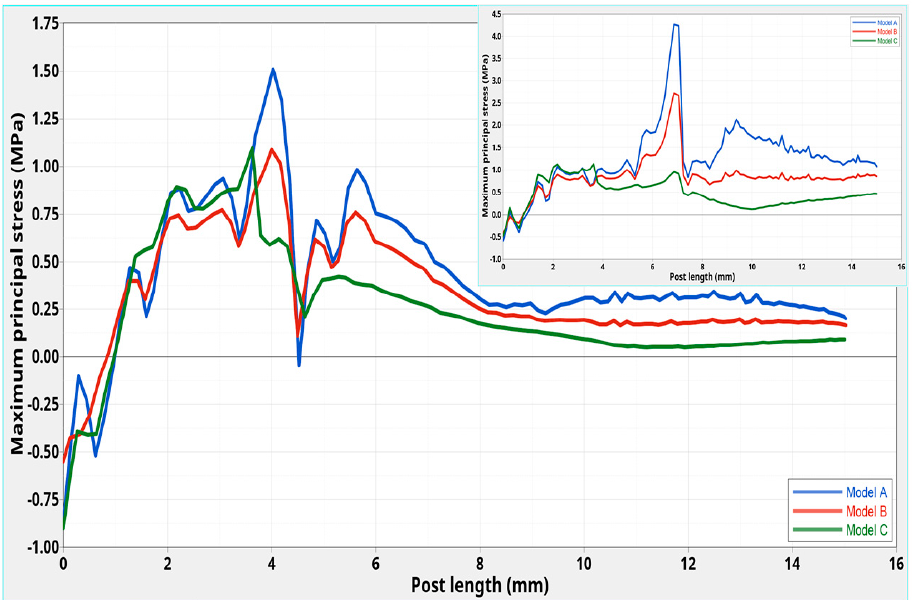
Figure 6. Models A, B, and C : maximum principal stress distributions at the interface between the post and surrounding structures from the coronal to the apical part. The inset is for corresponding models without a ferrule [12].